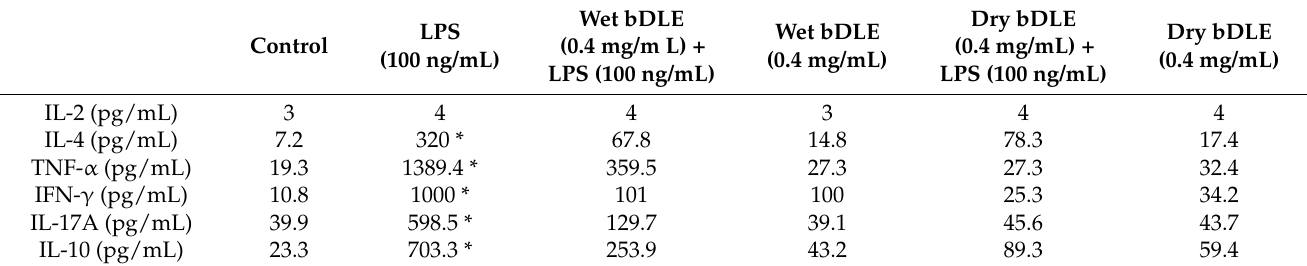
Table 6. Cytokine levels in LPS stimulated human PBMC treated with wet and dry